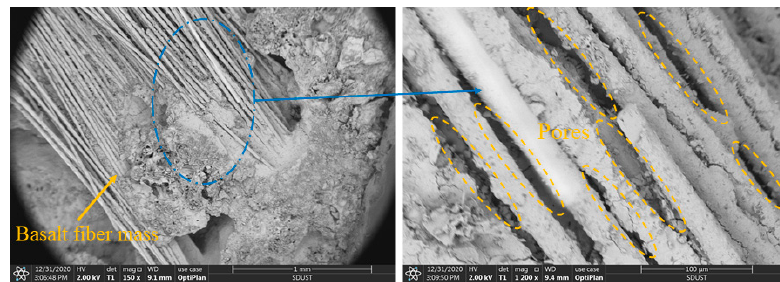
Figure 10. SEM image of thermal-insulation concrete with 20% fiber.